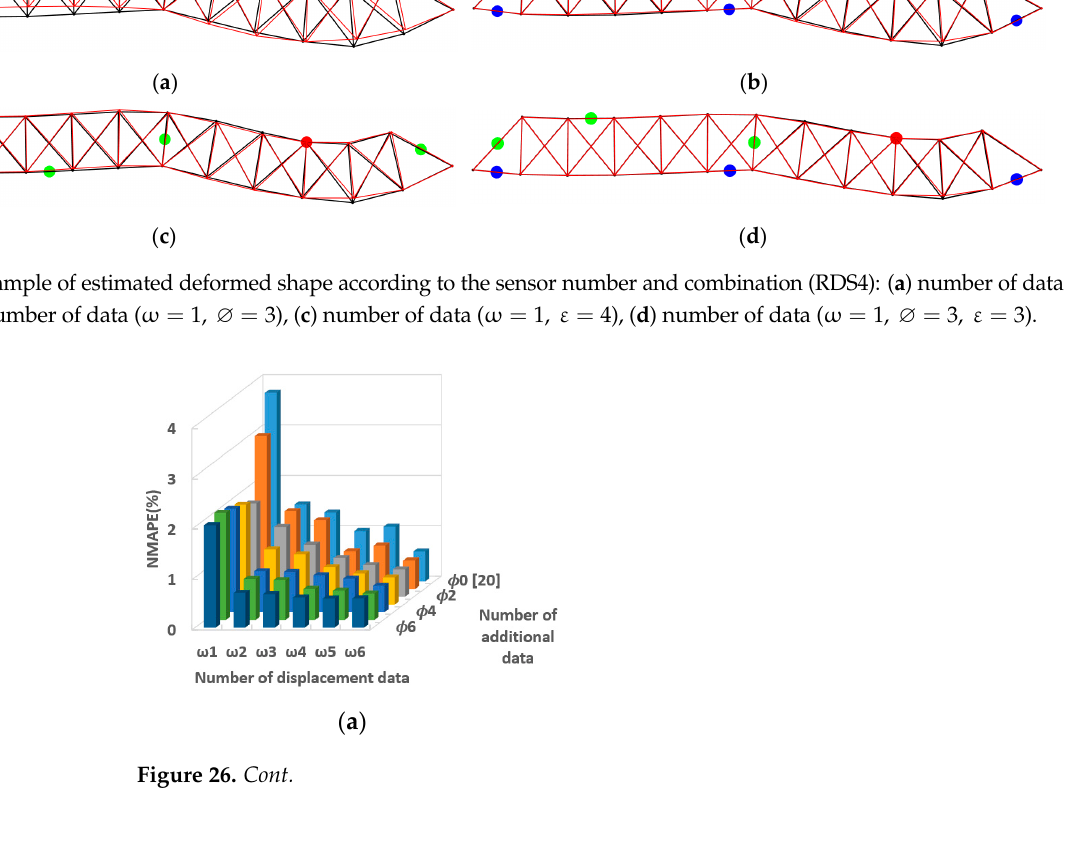
Table 8. Sensor location in the FEM model used for estimation (slope with displacement)—truss. Displacement (Node) Number of Slope Data (Element)